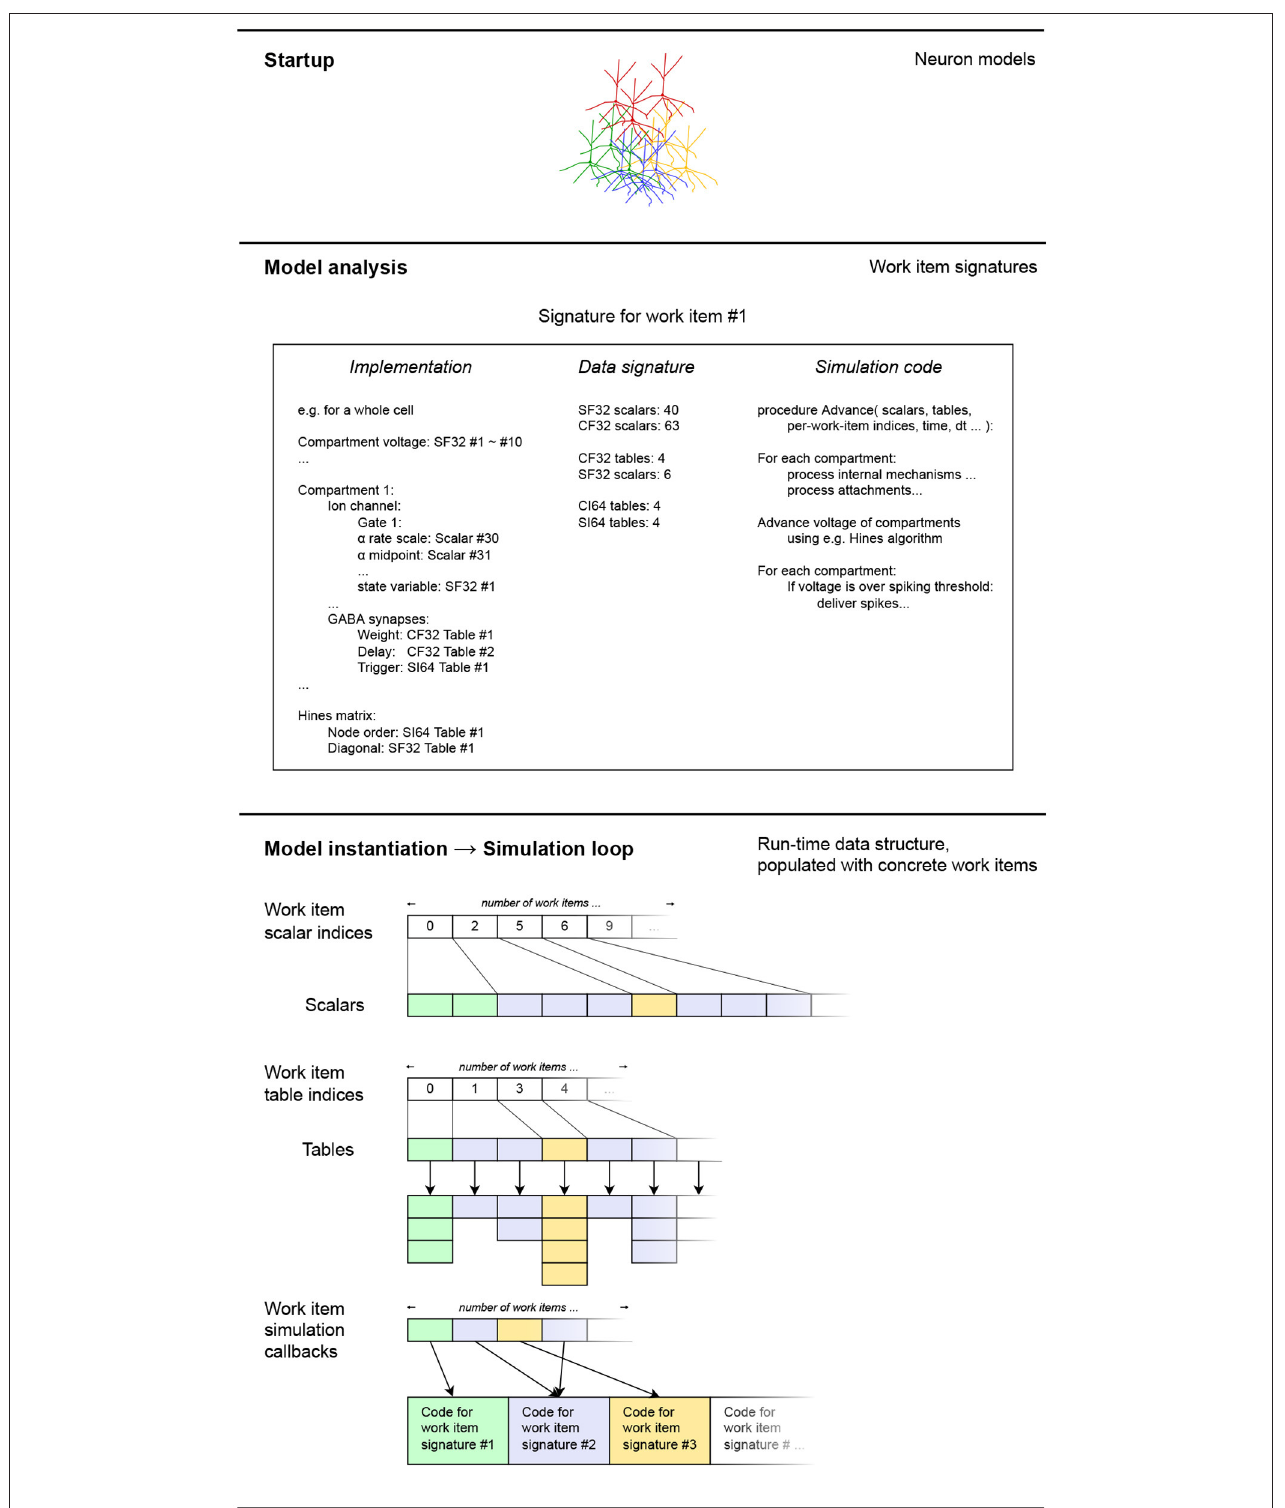
FIGURE 6 | A schematic representation of how the extracted work item signatures are converted to low-level data structures for efficient processing. For each work item, the set of scalars and work tables of each is appended into flat node-wide arrays, for each data type. Data types shown: CF32 = 32-bit floating-point constants, CF64 = 64-bit integer constants, SI64 = 64-bit integer variables. The different data types for scalars and tables have been omitted for clarity in the diagram, without loss of generality. Colors indicate different code-data signatures among work items.